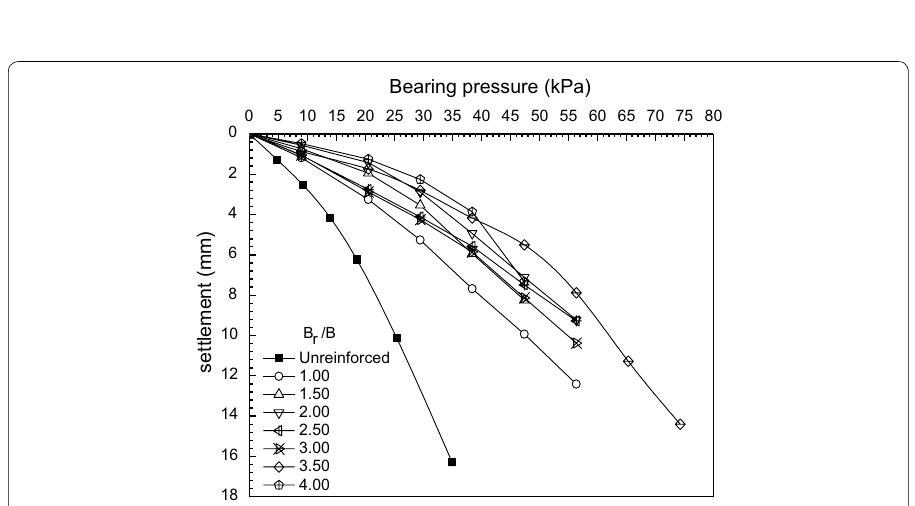
Fig. 8 Bearing pressure-settlement behavior of 50 mm square model footing on geojute reinforced sand (reinforcement depth ‘D r ’ 0.50B) =